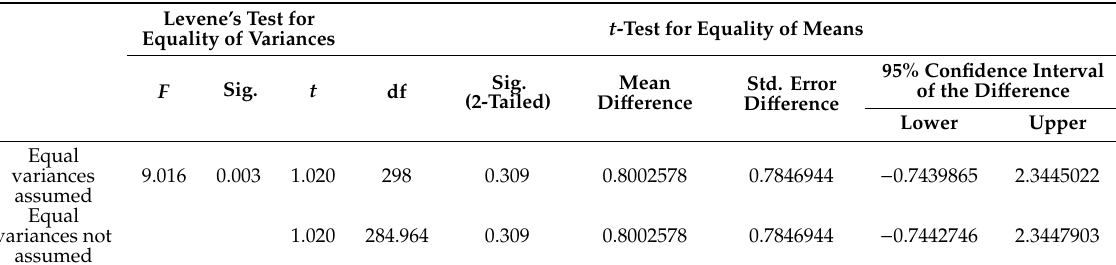
Table 10. T-Student test for Taste Index property based on ANN-PSO Method.